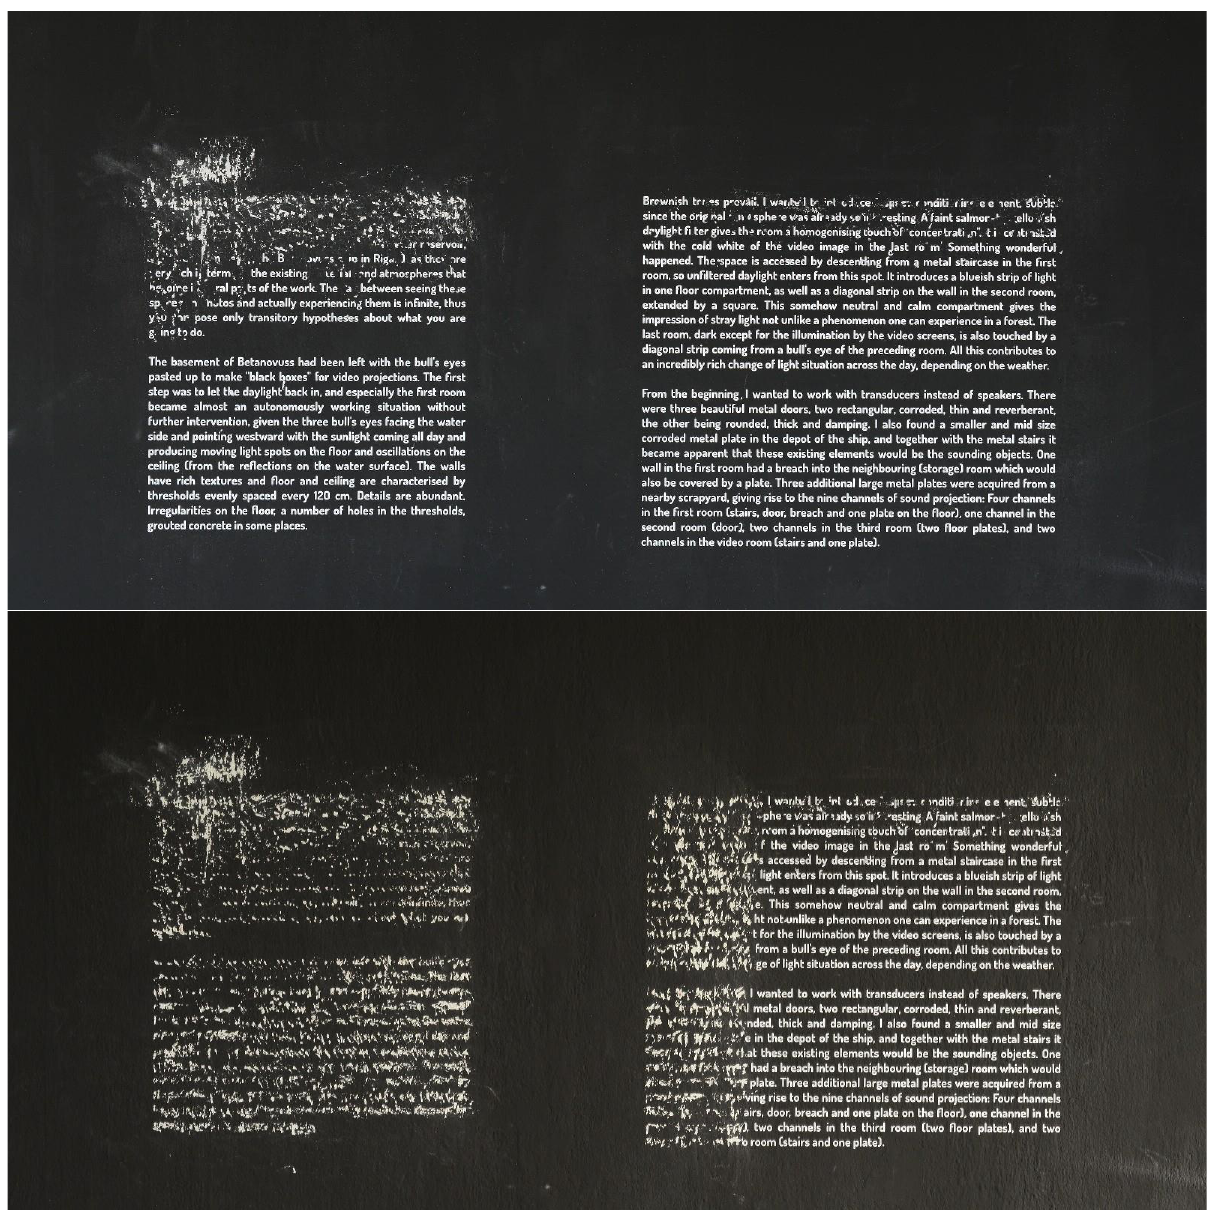
Figure 3 | 1st (top) and 35th (bottom) photograph in the vinyl text removal